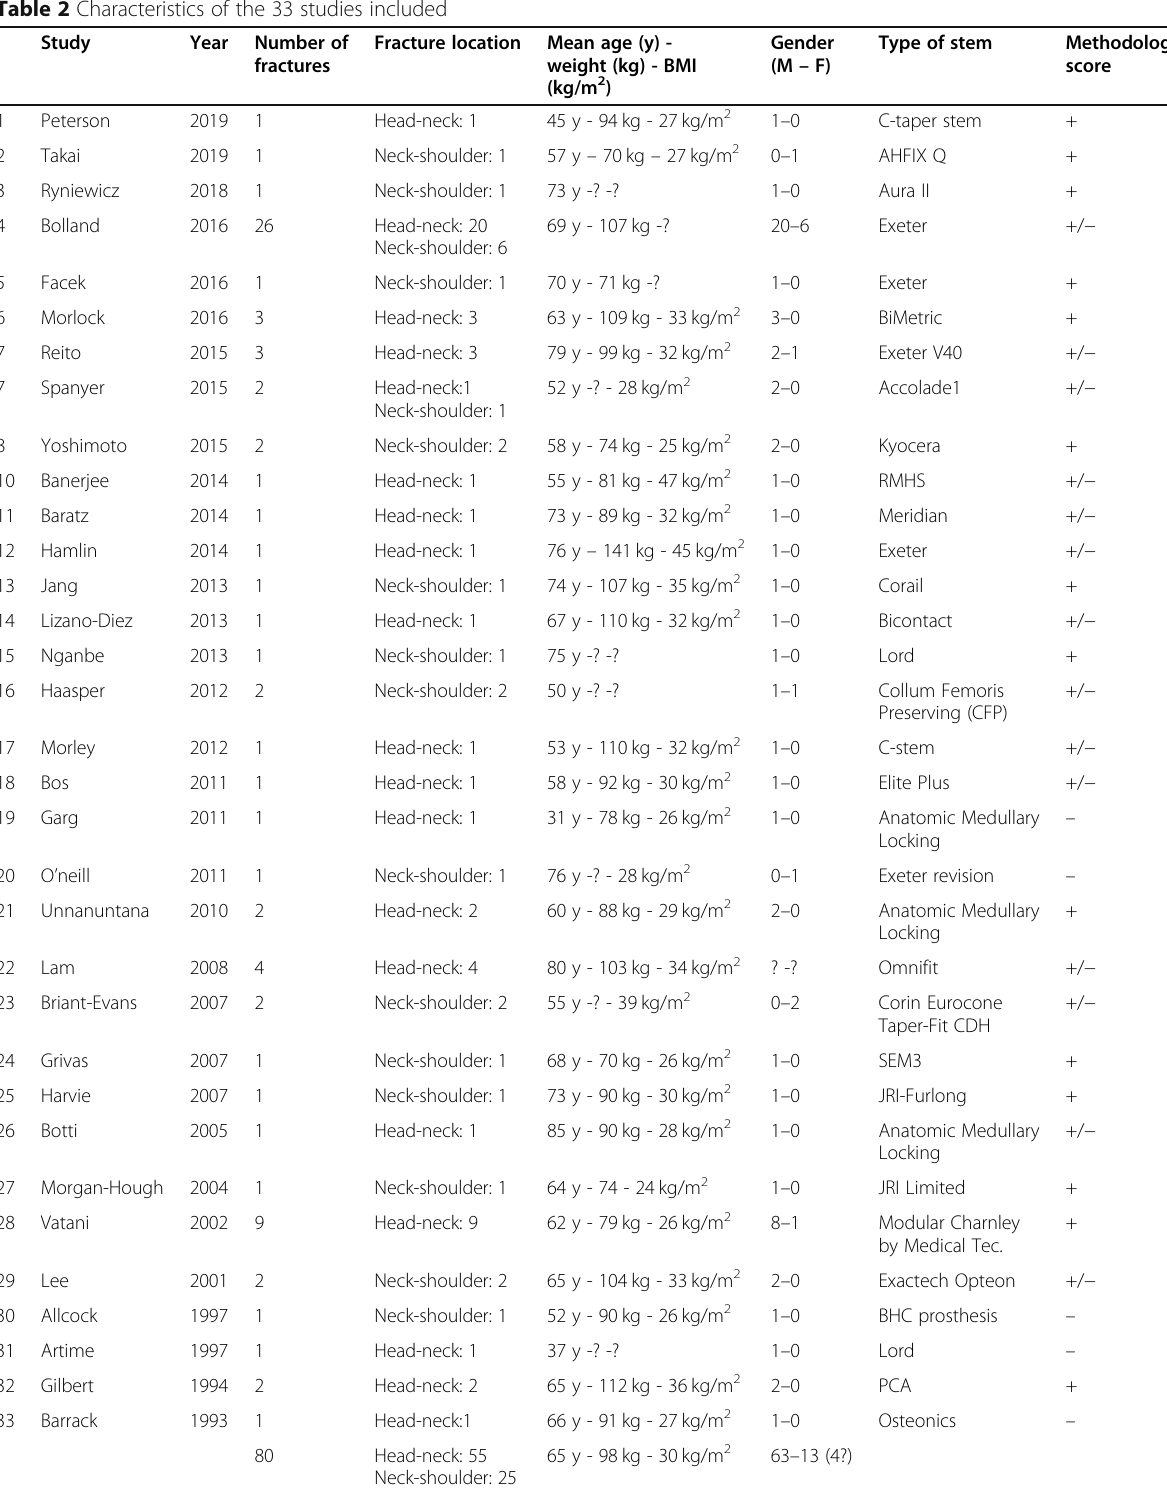
Table 2 Characteristics of the 33 studies